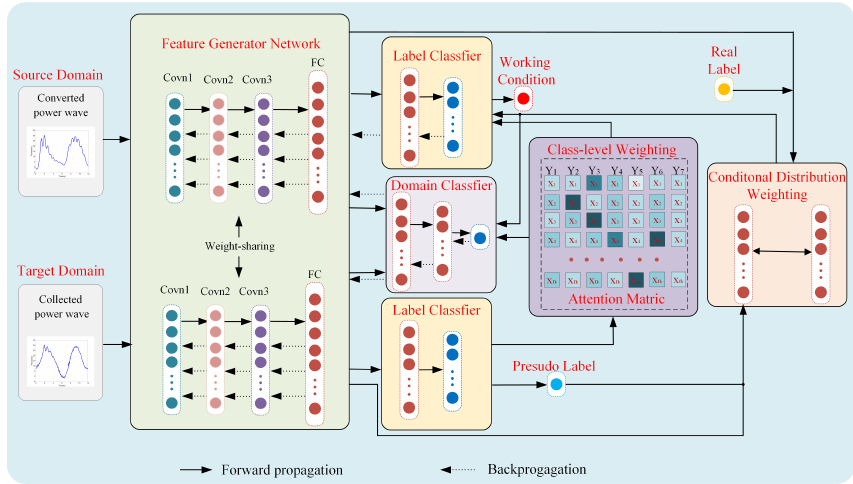
Figure 3. The framework of the proposed approach.